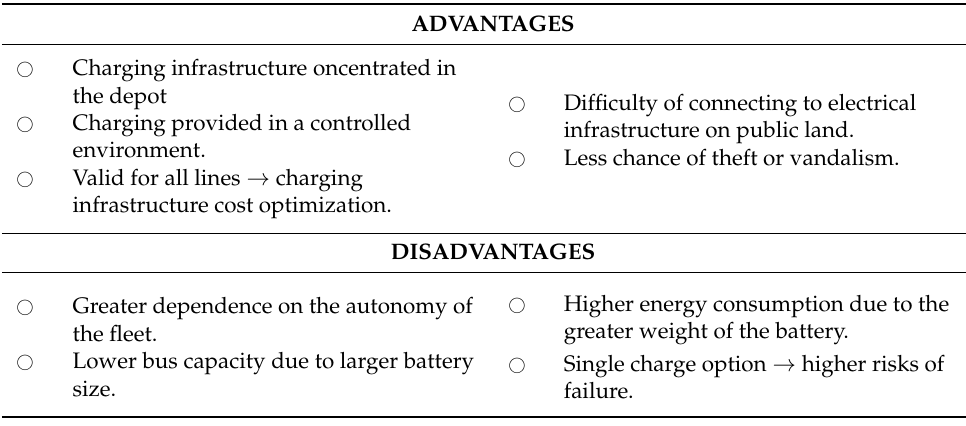
Table 1. Advantages and disadvantages of depot charging.